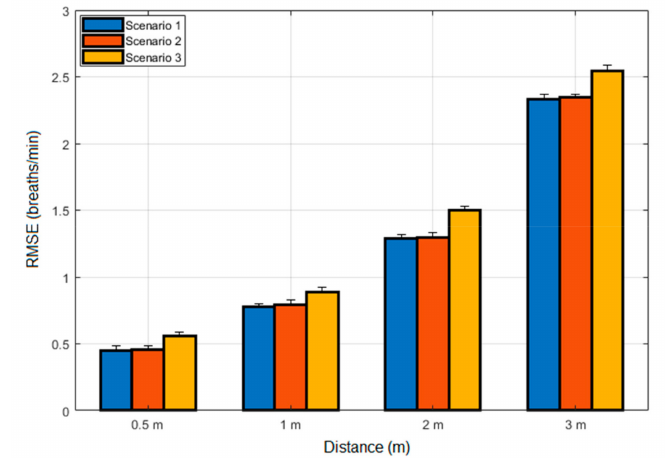
Figure 7. The e ff ect of clothing on the breathing rate (BR) measurements at di ff erent